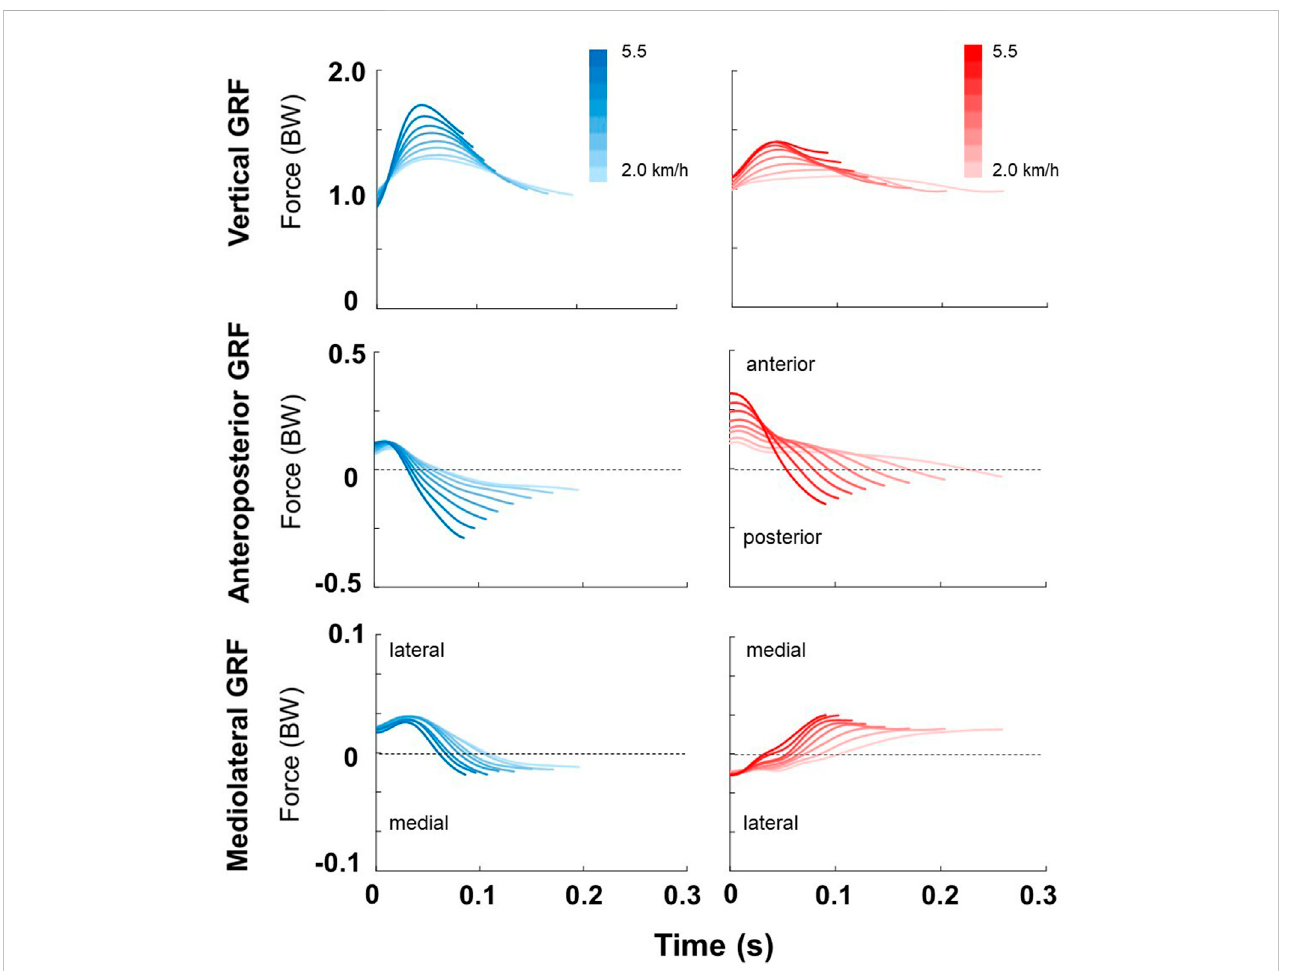
FIGURE 2 From top to bottom; vertical, anteroposterior, and mediolateral GRF of both the initial (blue) and the terminal (red) double limb stance across a range of walking speeds, respectively. Mediolateral directions are from the perspective of the leading limb during the DLS. The data was the average of 15 individuals with uTFA. In each plot, the vertical axis is normalized to the subject ’ s body weight (BW). The darkest and lightest colors represent the fastest (5.5 km/h) and slowest (2.0 km/h) walking speeds,